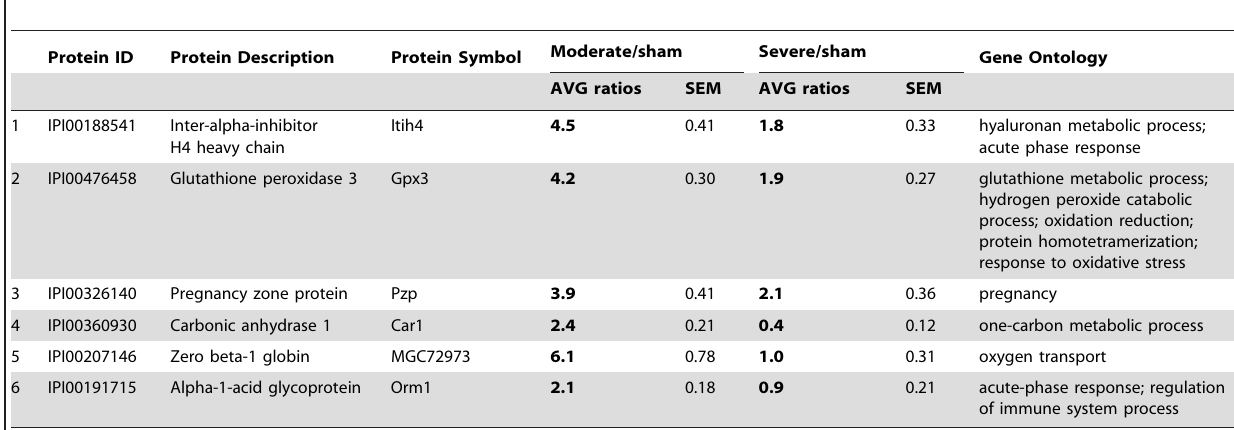
Table 3. Potential biomarkers of SCI severity identified by quantitative LC-MS/MS analysis of CSF from rats following experimental SCI.